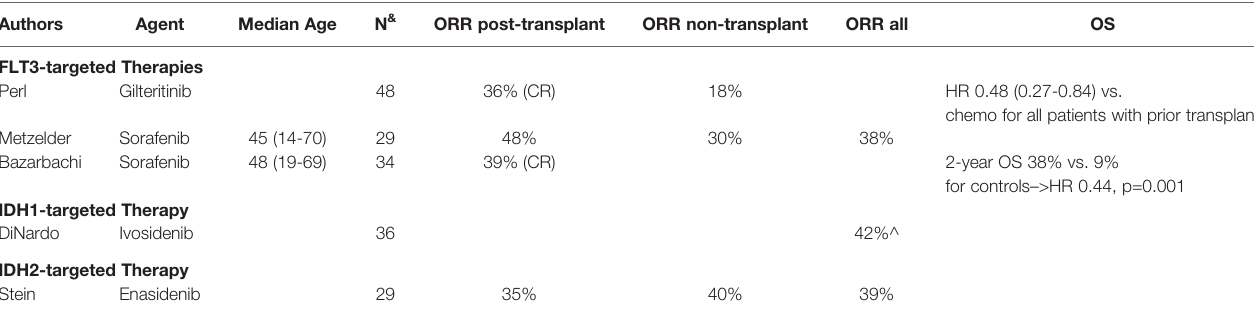
TABLE 3 | Studies using Targeted Therapy for Post-Allo-HCT